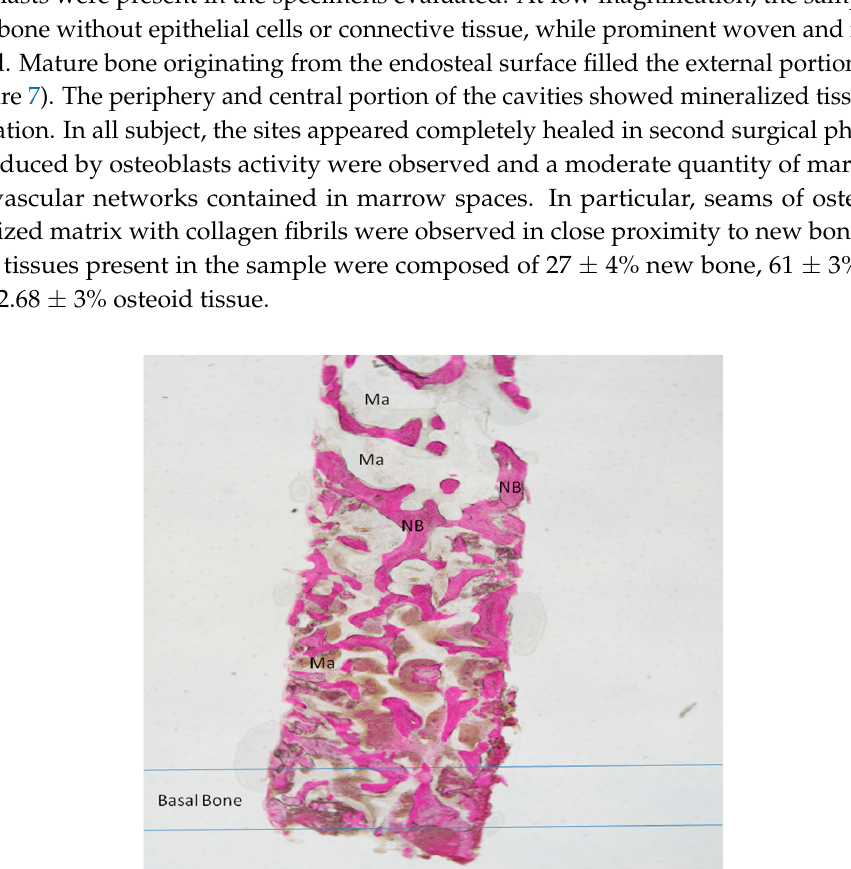
Figure 7. Group II. New Bone trabeculae (NB) were seen throughout the large marrow spaces (Ma). The basal bone with a small marrow spaces. Acid fuchsin and toluidine blue 4X.